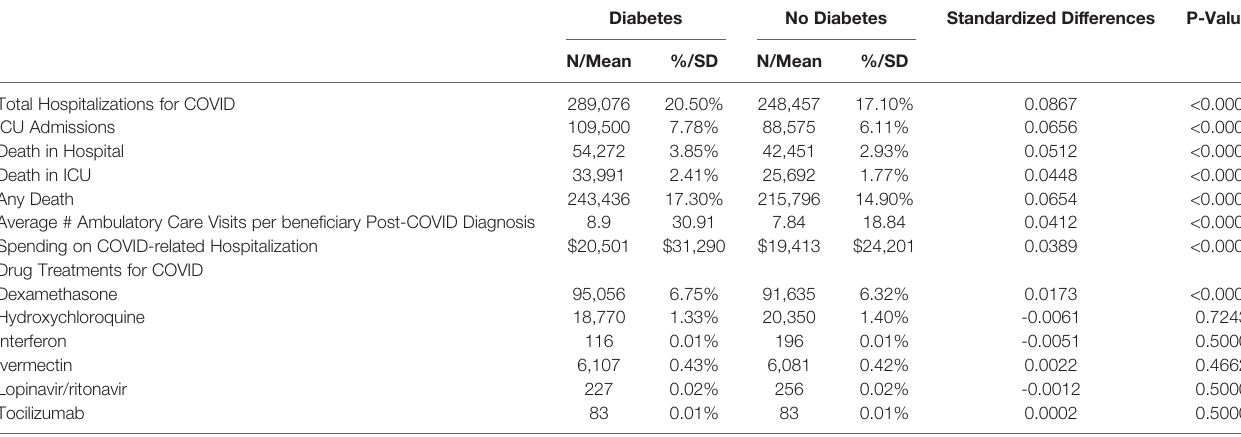
TABLE 3 | Weighted measures of Medicare utilization among bene fi ciaries with a prior diagnosis of COVID-19 in the 2020 claims